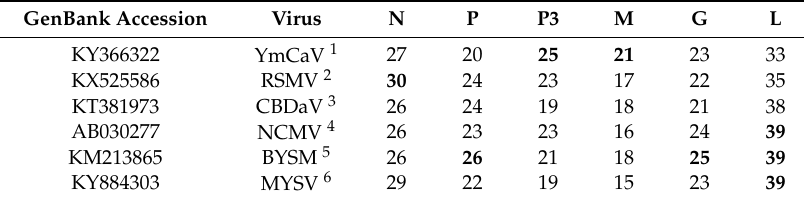
Figure S1. Symptoms displayed by bean transgenic line CNFCT16207 in the field (A) and mechanically inoculated plants in the greenhouse (B). Figure S2. Agarose gel electrophoresis of dsRNA extracted from: (1) Bean transgenic line CNFCT16207 collected in experimental fields; (2) mechanically inoculated common bean cv. Jalo Precoce and (M) 1 kb Plus DNA Ladder. Figure S3: RT-PCR detection of PvEV-1, PvEv-2, CPMMV, BRMV RNA-1 and RNA2, and BaCV using specific primers: Plant line CNFCT16207 collected in an experimental field (1 and 2), bean plants mechanically inoculated in the greenhouse cv. Jalo Precoce (3) and line CNFCT16207 (4); negative control (C-); 1 kb Plus DNA Ladder. Table S1: Primers sequences used for